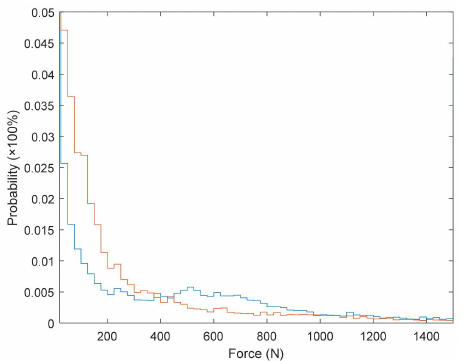
Figure 12. Histogram of force probability for the turbine (blue color) and pump (red color) modes; note forces below 20 N have been clipped, as they represent around 70% probability.